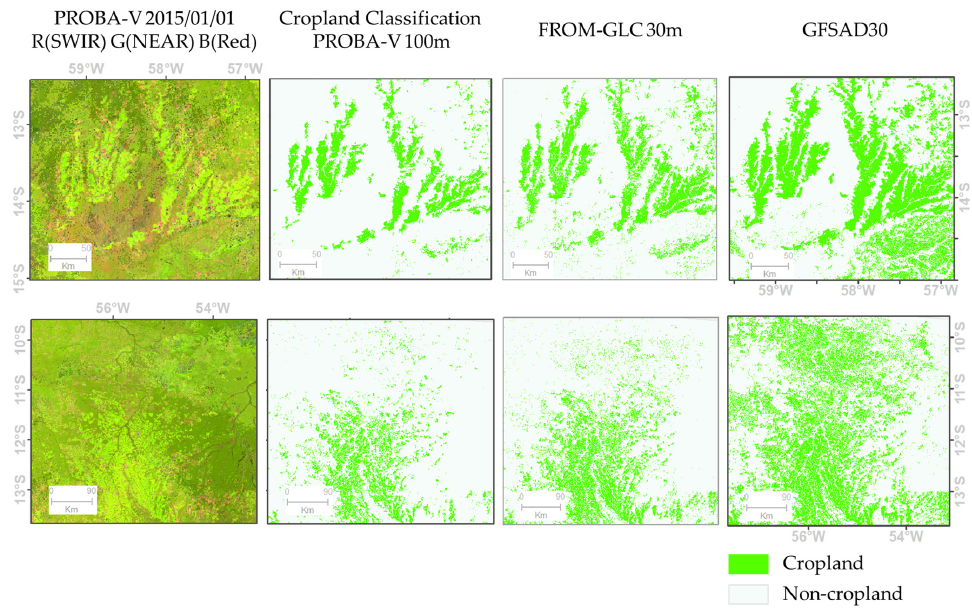
Figure 13. The Mato Grosso State cropland classification derived from PROBA-V 100 m spatial resolution data and comparison of the cropland maps in 2015. Note: The images have different scale bars in this figure.